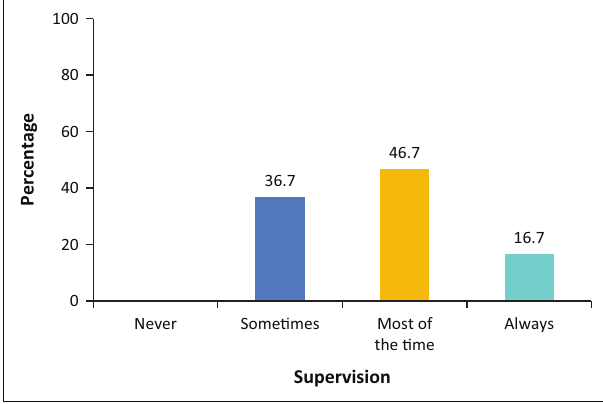
FIGURE 2: Consultant supervision in the